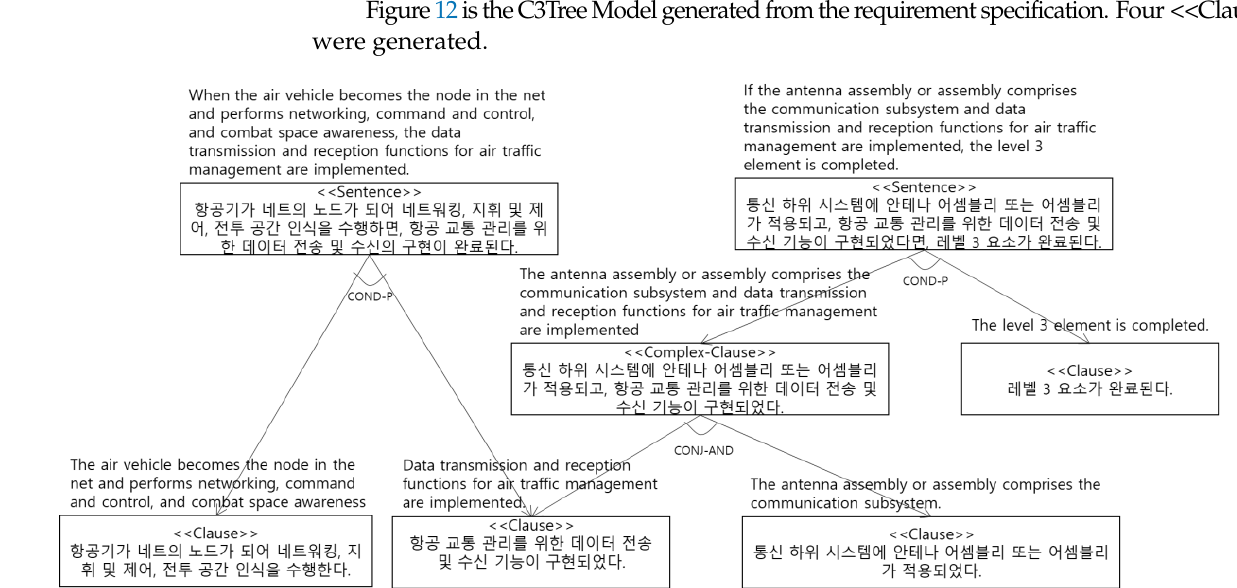
Figure 12. C3Tree Model generated from Requirement specifications. Figure 13 is the Cause-Effect Graph generated from the C3Tree Model. Four <<Clause>> are changed to nodes.